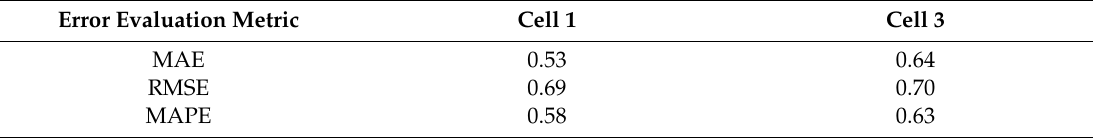
Table 7. Presentation of SoH estimation errors based on performance evaluation